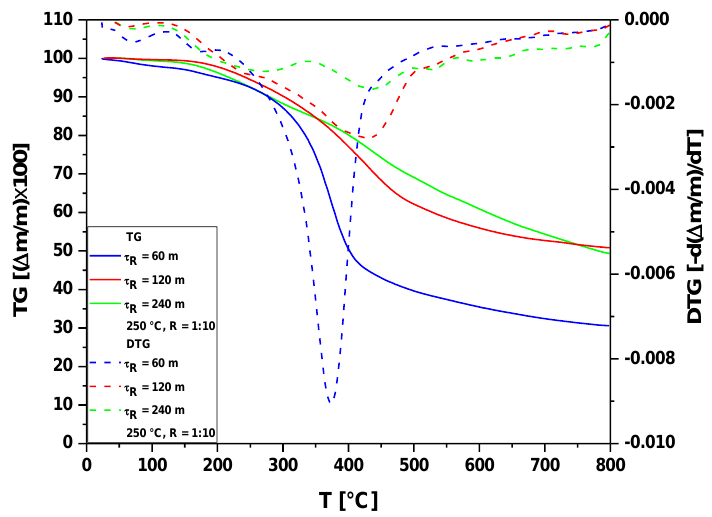
Figure 4. TG – DTG curves of hydro-chars obtained by the hydrothermal processing of corn stover at 250°C with a biomass/H 2 O ratio of 1:10 for 60, 120 and 240 min using a reactor of 18.75 L. From the TG – DTG curves for the hydro-chars obtained at 60 and 120 min, a small